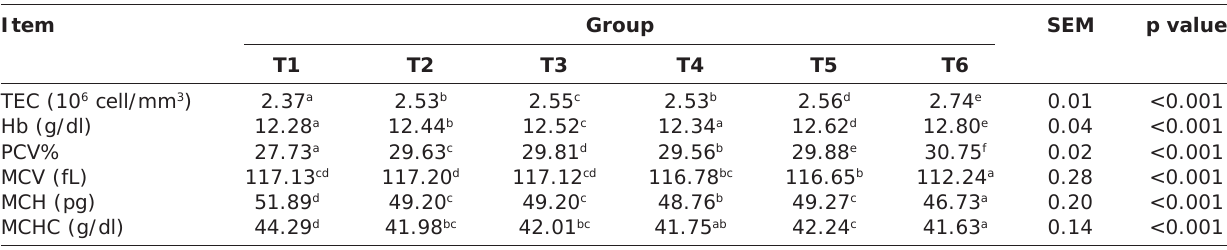
Table-2: Effect of shatavari and vitamin E on hematological parameters in different groups during winter season. Item Group SEM T1